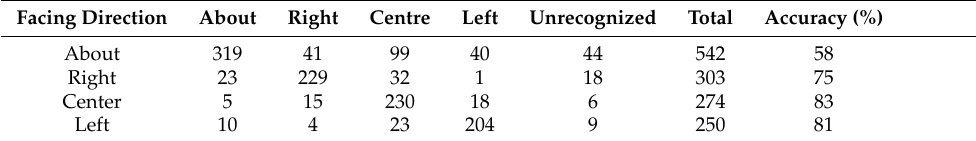
Table 6. Scene 2 estimating the head orientation: confusion matrix and accuracy.